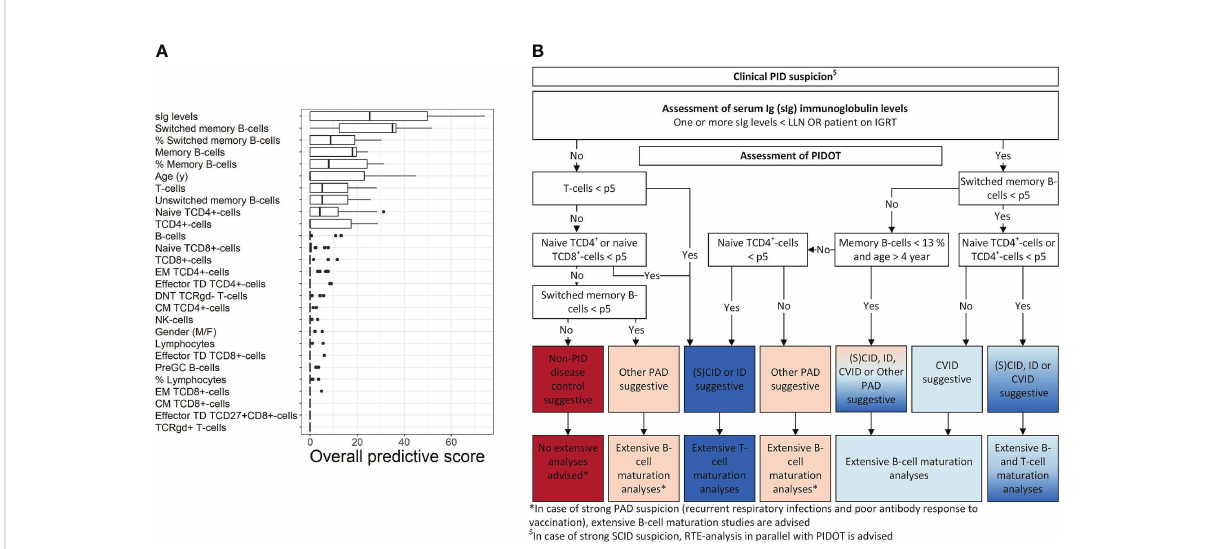
FIGURE 3 PIDOT decision-tree algorithm. Using supervised machine learning, pruned decision trees were trained with 24 FCM-based PIDOT features supplemented with age- sex- and/or the age-adjusted serum Ig levels (including IgG, IgG 2 , IgG 3 , IgA, and IgM, in case no IGRT at time of basic immunological screening) of non-PID disease controls and lymphoid-PID patient samples. (A) Box plots of the overall importance score values of the individual (discriminating) features for distinguishing of lymphoid-PID (subtypes) vs. non-PID disease controls. Only the importance score values of the pruned decision trees with cross-validated balanced accuracy ≥ 80% are shown. Adding models with a lower balanced accuracy did not impact the importance score values of the individual features. The boundaries of the box plots represent the 25th and 75th percentiles. A black vertical line indicates the median. (B) Decision-tree algorithm for early PID screening of lymphoid-PID to guide (more) extensive fl ow cytometry. CM, central memory; non-PID DCs, non-PID disease controls; DNT, double-negative T cells; EM, effector memory; CID, combined immunode fi ciency; CVID, common variable immunode fi ciency; sIg, serum immunoglobulin; ID: immune dysregulation; NK, natural killer; PAD, predominantly antibody de fi ciency; SCID, severe combined immunode fi ciency; TCR, T-cell receptor; TD, terminal